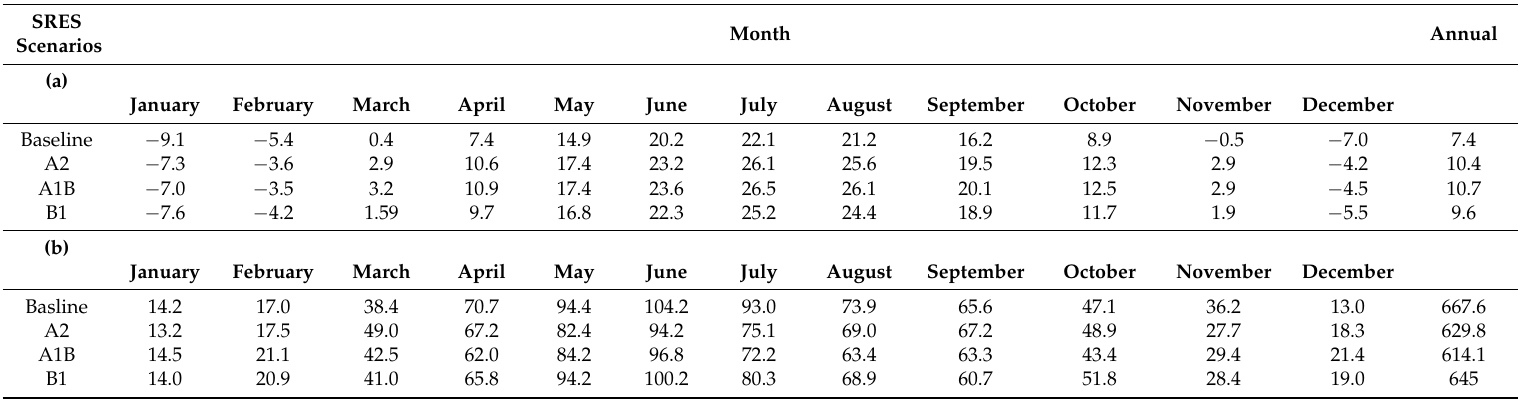
Table A5. Projected climate change scenarios (based on the Special Report on Emission Scenarios, SRES, IPCC 2007, CMIP 3 † ) for the mid-21st century (2046–2065) in SKW. ( a ) Average annual and monthly temperature the baseline (1987–2000); ( b ) Cumulative annual and average monthly precipitation with baseline (1987–2000).